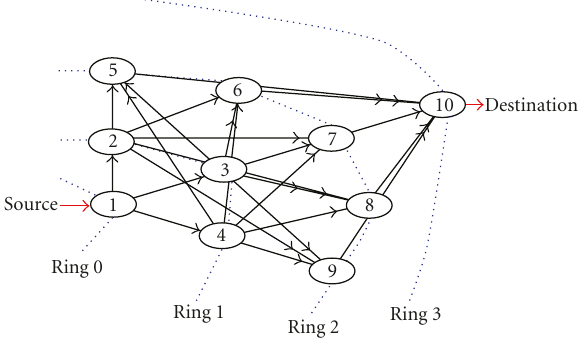
Figure 4: Network [1 3 5 1].